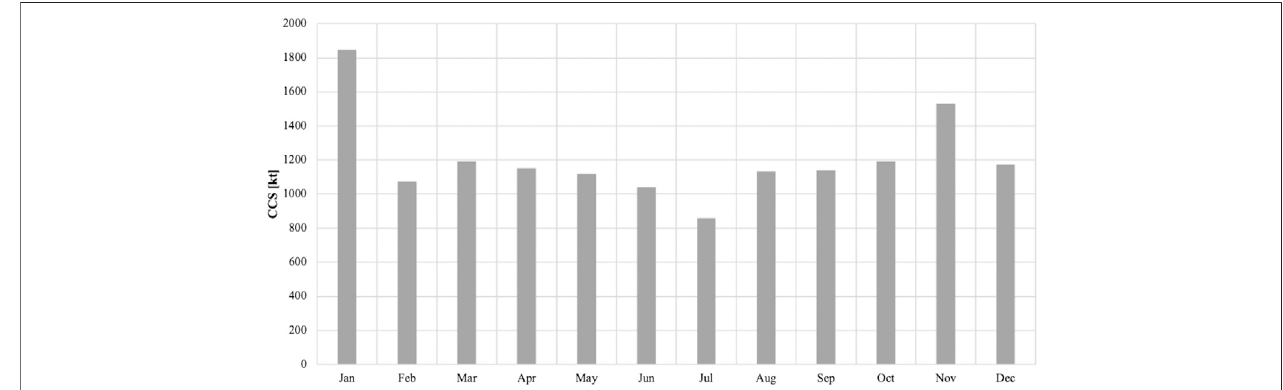
FIGURE 8 | Monthly carbon sequestration (kt-CO 2 ).